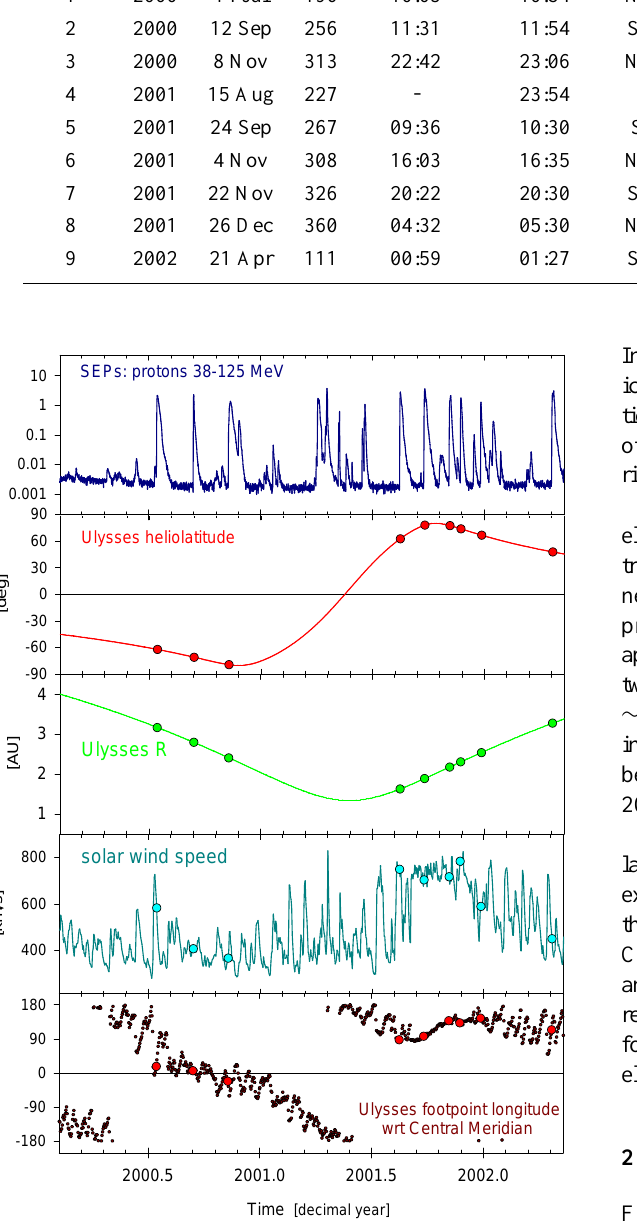
Fig. 1. Overview of Ulysses SEP high-latitude measurements. From top to bottom panels: SEP fluxes for protons 32–125 MeV (COSPIN/KET); Ulysses heliographic latitude; Ulysses distance from the Sun; solar wind speed (SWOOPS); longitude of the nom- inal footpoint of a Parker spiral field line through Ulysses, with re- spect to Central Meridian (the footpoint position is calculated by using the measured solar wind speed). The dots on the plot are at the start time of the 9 large SEP events considered in the onset time